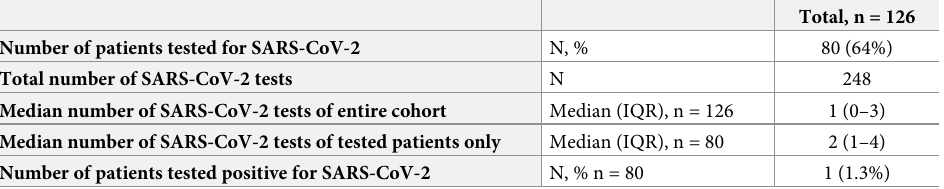
Abbreviations: SARS-CoV-2, Severe Acute Respiratory Syndrome Coronavirus